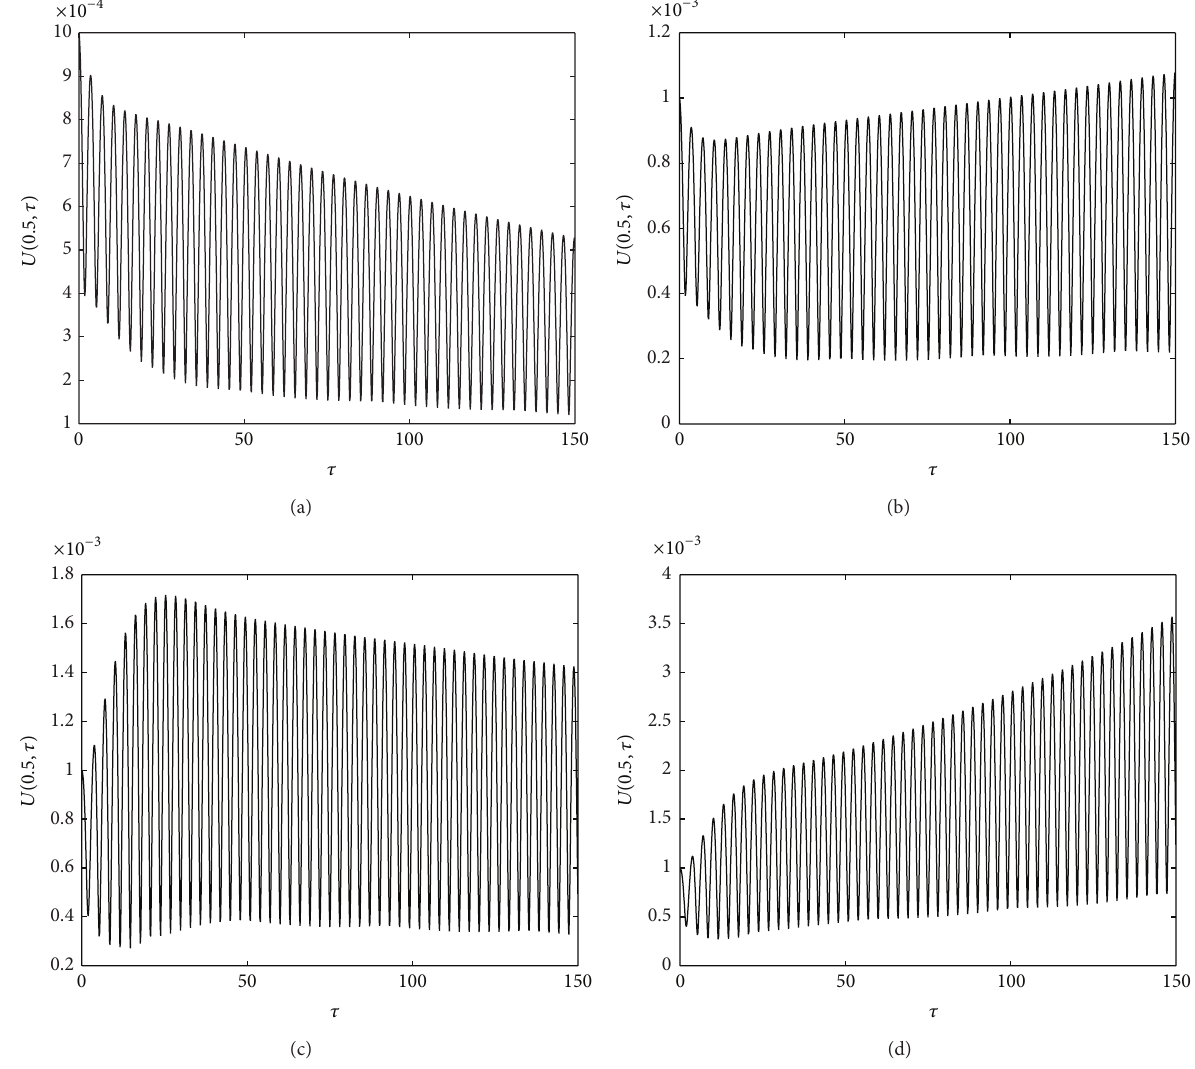
Figure 7: Dynamic responses of transverse displacements with 𝑍 𝑝 = 5 and 𝜁 = 0.05 . (a) 𝑍 𝑝 Ω/2𝜔 ∗ = 1.0 𝛽 = 0.16 , (b) 𝑍 𝑝 Ω/2𝜔 ∗ = 1.0 𝛽 = Ω/2𝜔 ∗ = 1.1 𝛽 = 0.38 , and (d) 𝑍 Ω/2𝜔 ∗ = 1.1 𝛽 = 0.40 0.18 , (c) 𝑍 𝑝 𝑝